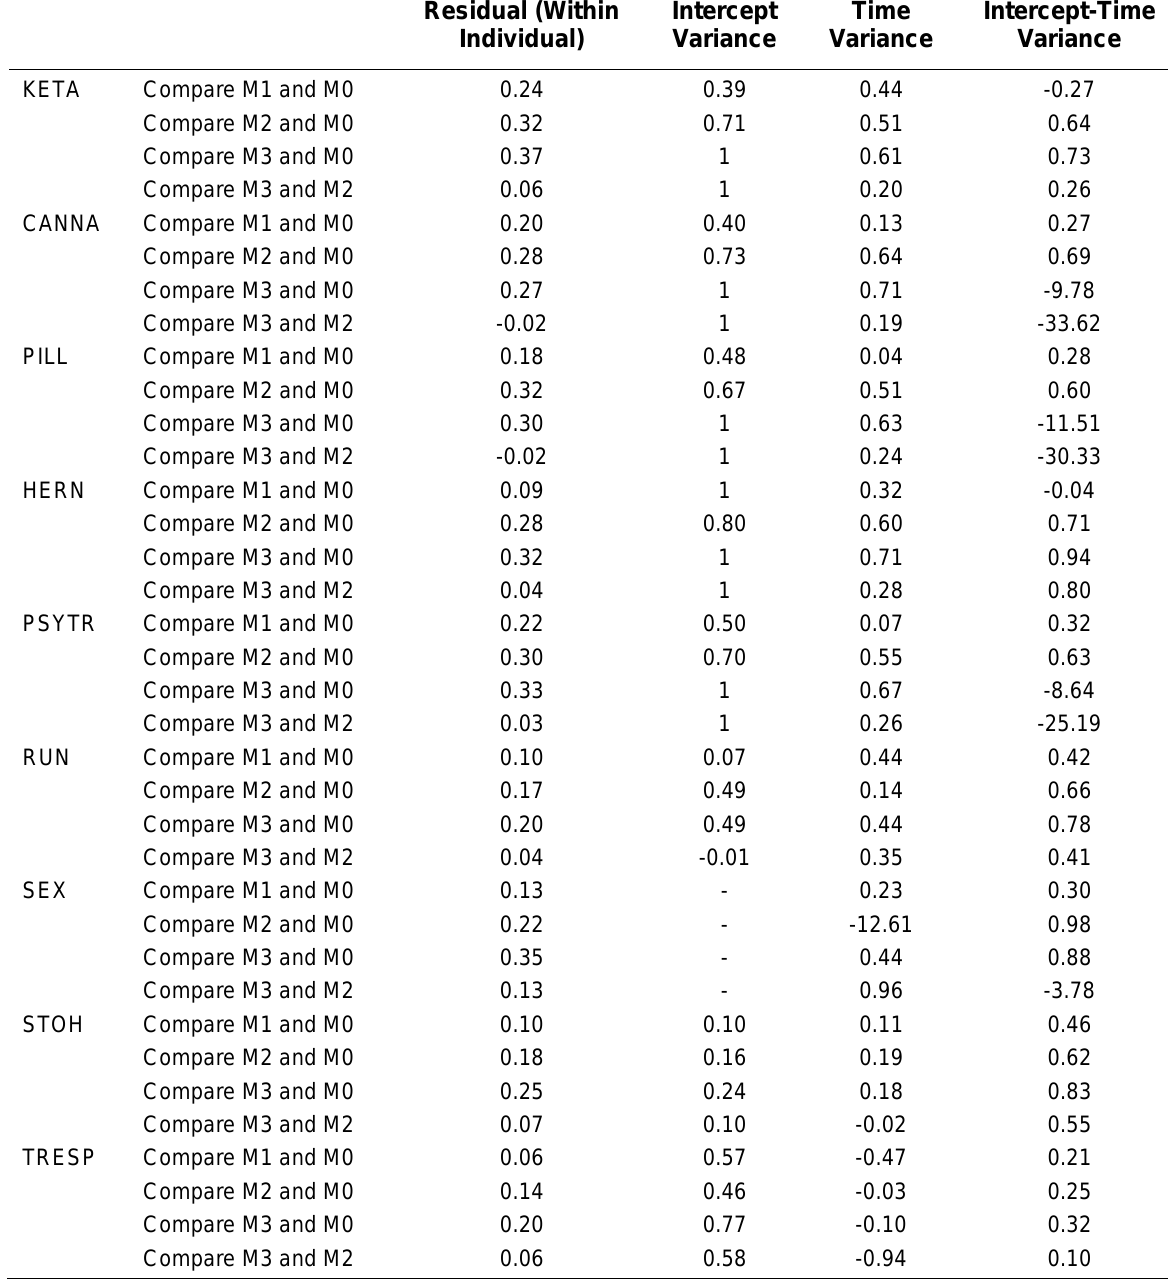
Pseudo-R 2 for IGC with Subjects who Joined the Tier 1 Program being Experimental Subjects Residual